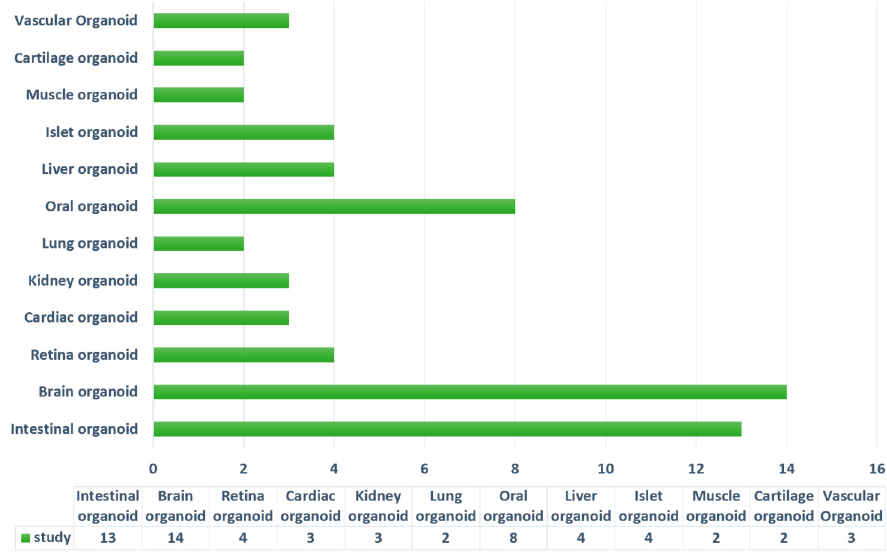
Figure 4. A bar chart representing the number of different types of organoids within the included articles. Table 1. Summary of stem cell types, hydrogel types, and mechanisms used for engineering different types of